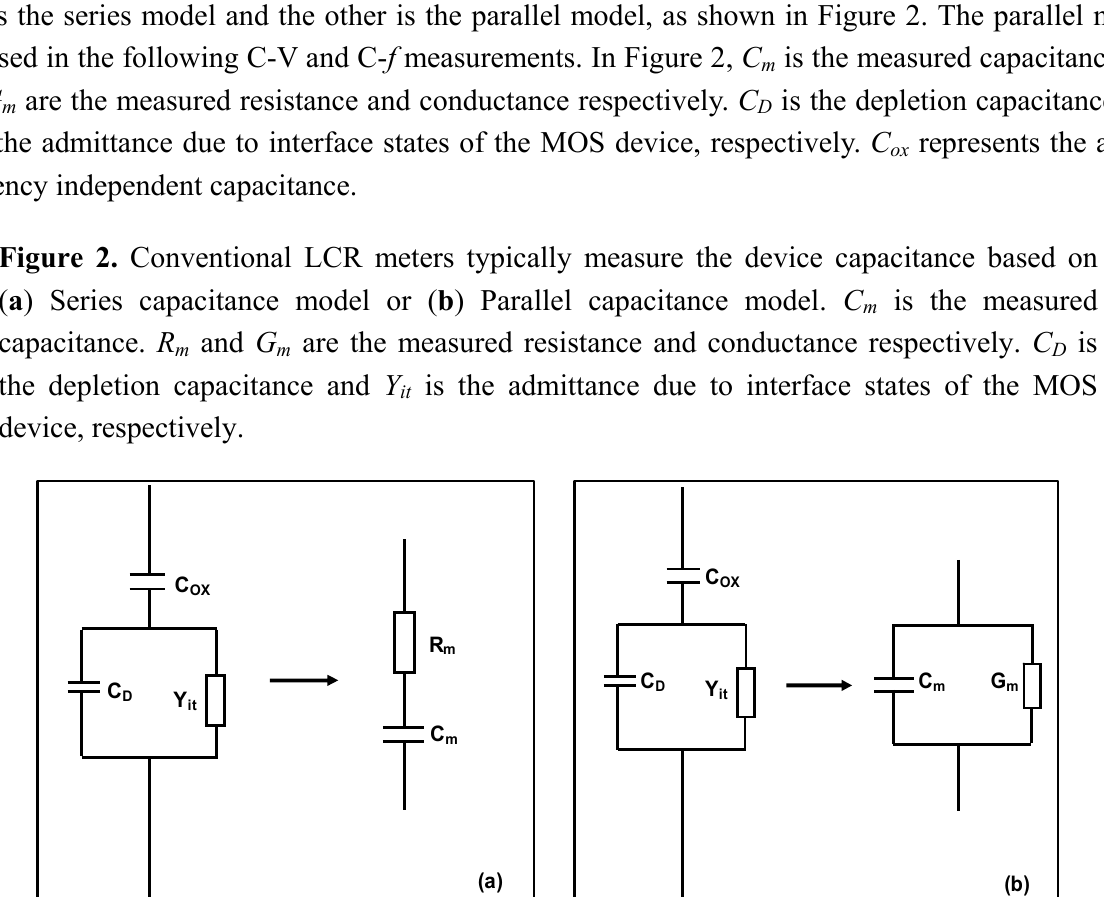
Figure 2. Conventional LCR meters typically measure the device capacitance based on ( a ) Series capacitance model or ( b ) Parallel capacitance model. C